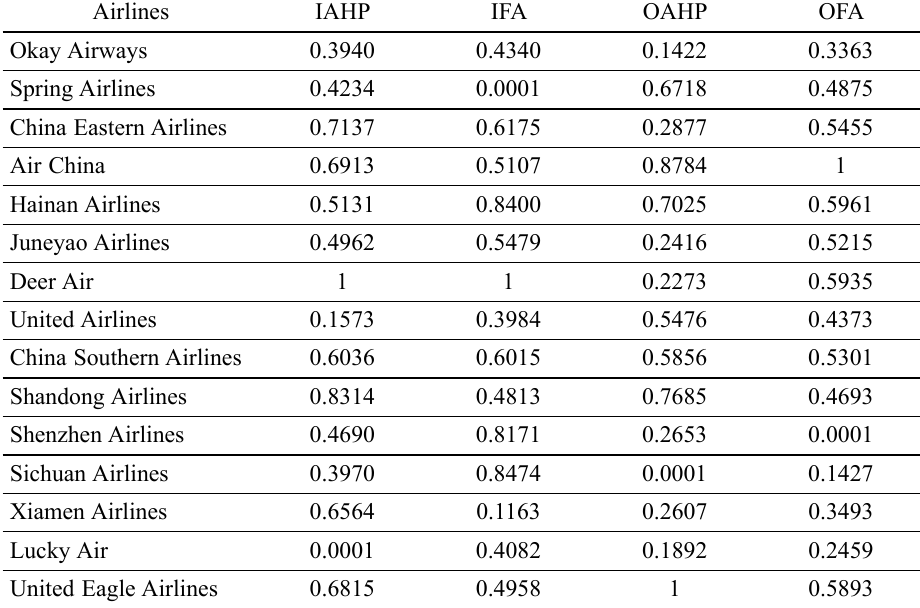
Table 15. Input and output data through Maximum Differential